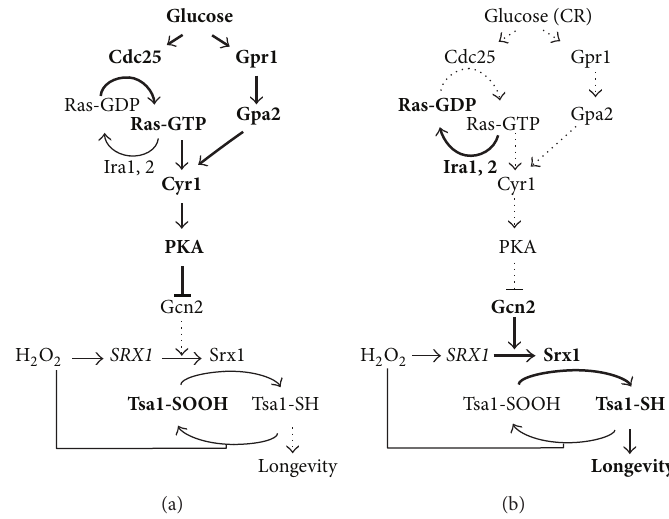
Figure 1: Model for how CR elicits Tsa1 and Srx1-dependent H 2 O 2 resistance and life span extension. (a) At a high concentration of glucose, when increased signaling through both the Ras-Cyr1 and the Gpr1-Gpa2-Cyr1 signaling branches stimulate PKA activity (Box 1), H 2 O 2 stress activates Yap1/Skn7-dependent transcription of the SRX1 mRNA but its translation is attenuated by PKA. As a consequence, Srx1 production is diminished and Tsa1 hyper-oxidized and inactivated. (b) During CR, PKA activity is reduced relieving the translational inhibition of the SRX1 mRNA in a Gcn2-dependent manner to provide more Srx1 protein and, as a consequence, more reduced, peroxidase-active